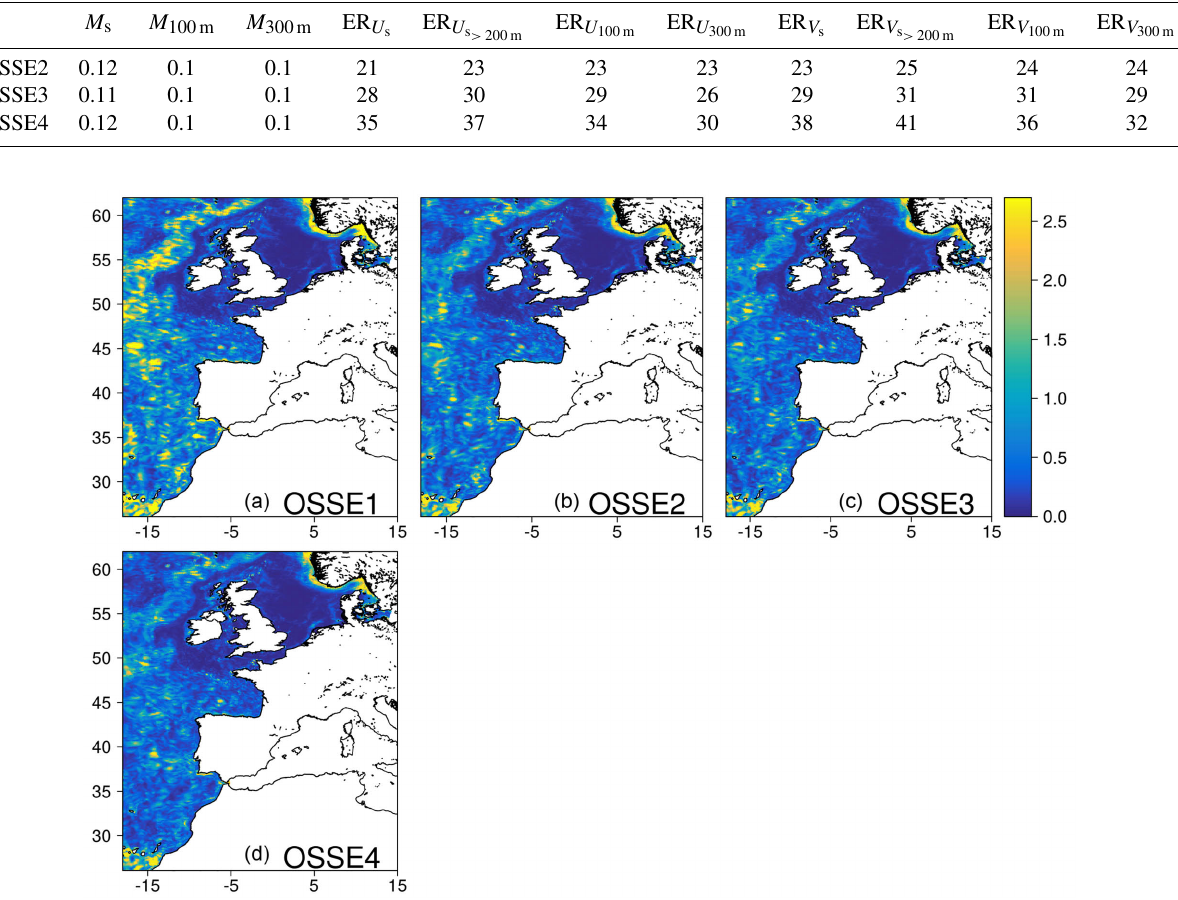
Figure 8. Ocean zonal currents at the surface: variance of misfits in the ocean analysis over the IBI domain during the period from August to September 2009. The results are obtained by comparing the zonal currents of the “truth” data with the ocean analysis in the OSSE1 (a) , OSSE2 (b) , OSSE3 (c) and OSSE4 (d) experiments. Values are expressed as 10 − 2 m 2 s − 2